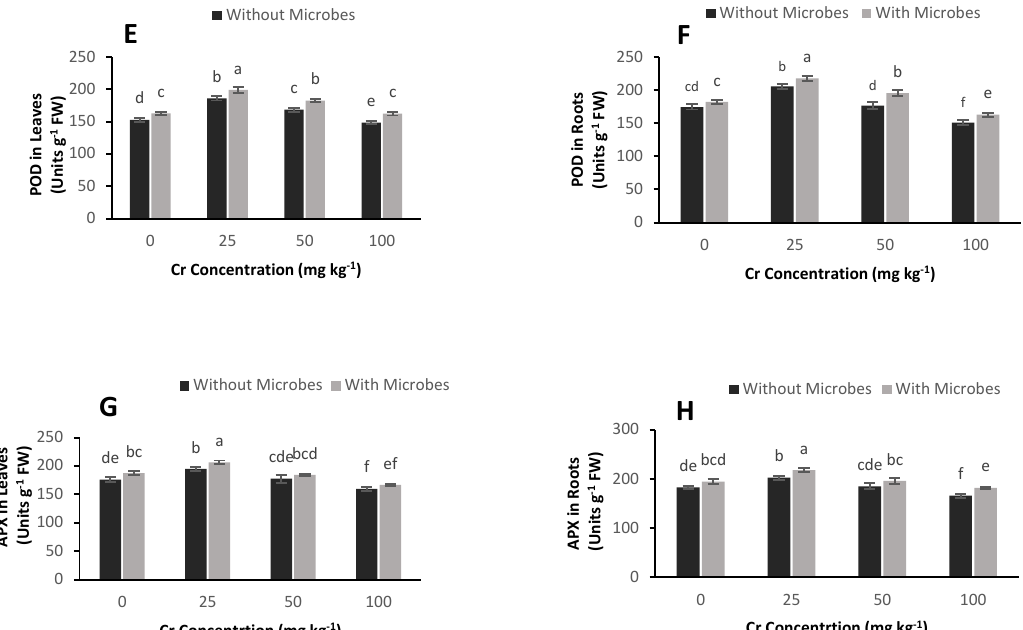
Figure 5. Influence of the different Cr levels (0, 25, 50, 100 mgkg −1 ), with and without peat-moss-based microbial inoculation, on SOD in leaves ( A ), SOD in roots ( B ), CAT in leaves ( C ), CAT in roots ( D ), POD in leaves ( E ), POD in roots ( F ), APX in leaves ( G ) and APX in roots ( H ) of wheat plants. Bars indicate the mean values with standard SD of three replicates. Different bar letters show significant changes among various treatments at p < 0.05.